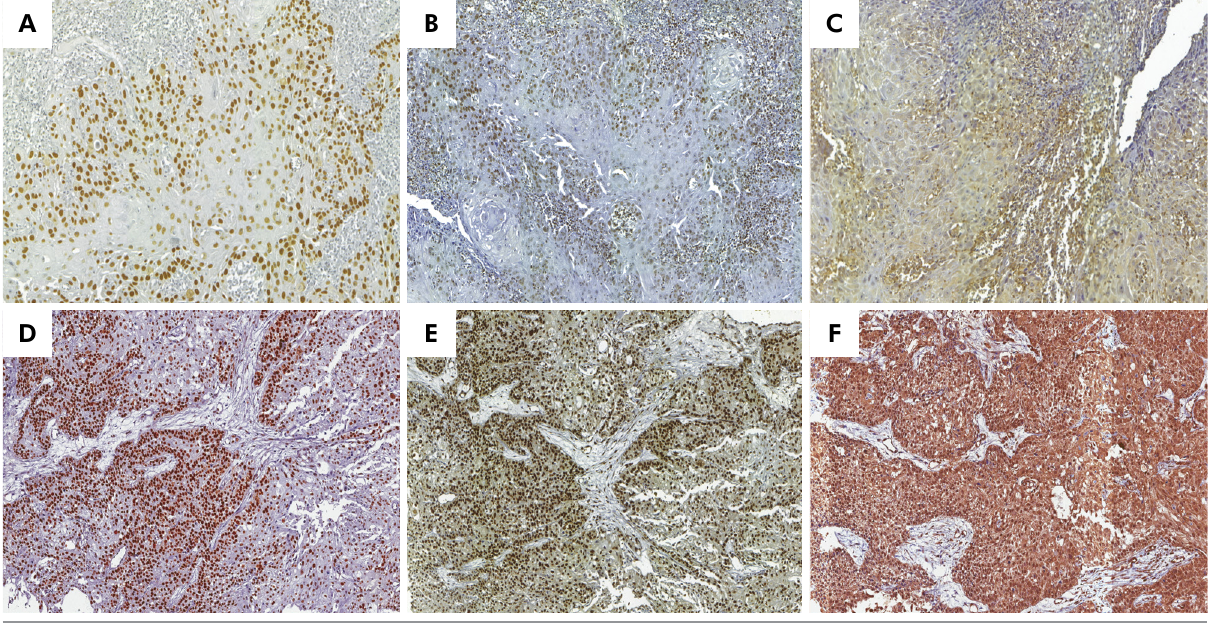
Figure. Immunohistochemical features of p53, p16, and Bax in OTSCC in young and elderly patients. (A) and (D) Nuclear immunoexpression of p53 mainly at the periphery of tumor nests in young and elderly patients, respectively (200x). (B) and (E) Nuclear positivity of p16 predominantly observed at the periphery of tumor nests in young patients and diffuse staining detected in elderly patients, respectively (200x). (C) and (F) Strong cytoplasmic immunopositivity for Bax localized diffusely in all tumor nests in young and elderly patients, respectively (200x).